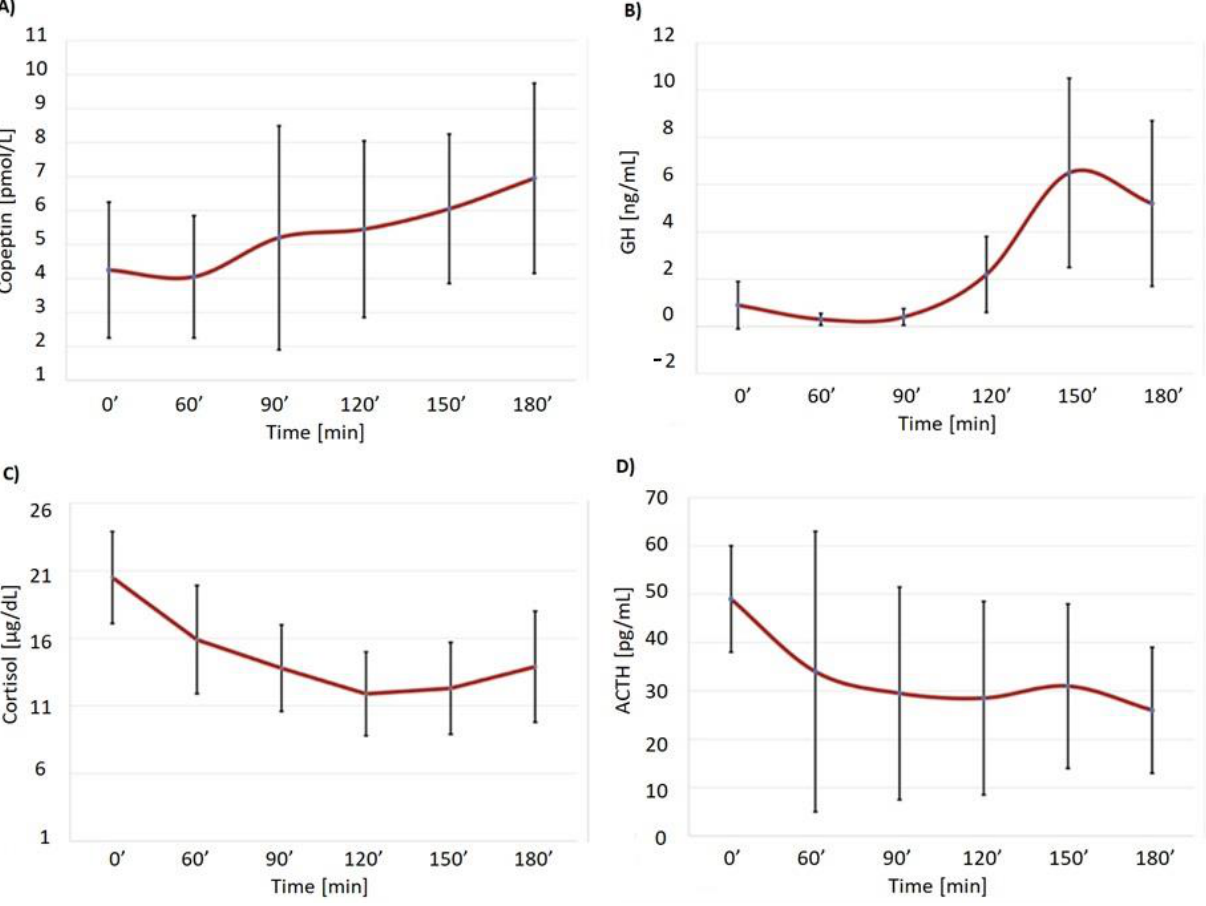
Figure 1. Copeptin ( A ), GH ( B ), cortisol ( C ) and ACTH ( D ) secretion during GST (means ± SD) in patients with satisfactory initial cortisol concentrations, but no further cortisol increment during stimulation.